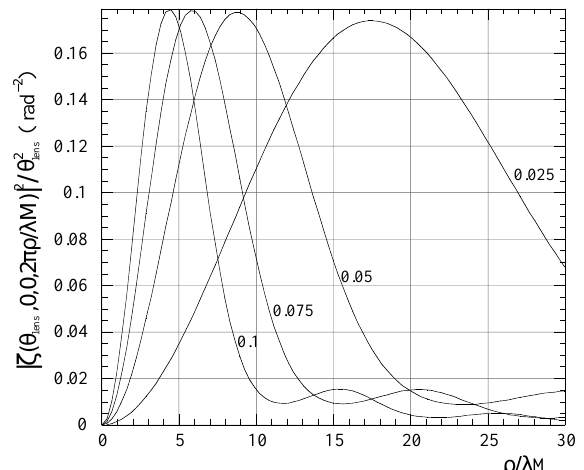
FIG. 4. Normalized OTR intensity distributions in the image plane (in units of u (cid:50) (cid:108)(cid:101)(cid:110)(cid:115) ) for different lens angular acceptances u (cid:108)(cid:101)(cid:110)(cid:115) (cid:115) bg (cid:173) (cid:49)(cid:48)(cid:48)(cid:48) (cid:100) . Numbers on the curves are values of u (cid:108)(cid:101)(cid:110)(cid:115) . Spatial coordinates in this figure, as well as in the following figures, are expressed in units of l (cid:77) , i.e., the wavelength increased by a factor of the lens magnification.